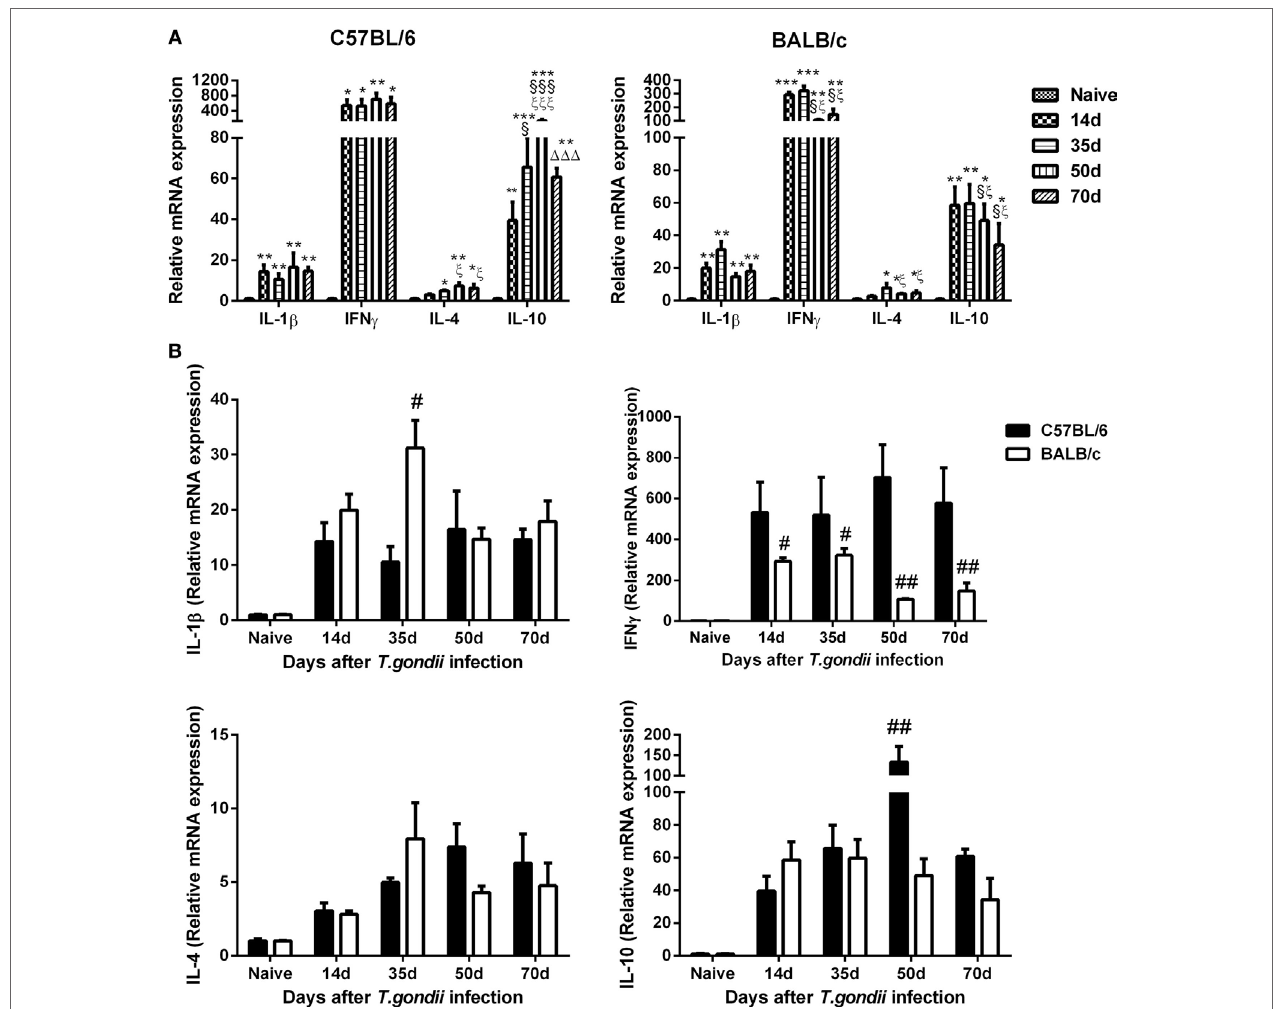
FigUre 4 | Relative mRNA expressions of interleukin (IL)-1 β , interferon gamma (IFN γ ), IL-4, and IL-10 in the brain tissues of Toxoplasma gondii Pru strain-infected C57BL/6 and BALB/c mice were detected by using quantitative real-time reverse transcription-polymerase chain reaction. (a) IL-1 β , IFN γ , IL-4, and IL-10 expressions in the brains of C57BL/6 and BALB/c mice. (B) Comparison of IL-1 β , IFN γ , IL-4, and IL-10 levels in the brains of C57BL/6 and BALB/c mice. Values are means from triplicate measurements, and data are presented as mean ± SD. There were four mice per group. The data shown are representative of those from two different experiments. * P < 0.05, ** P < 0.01, and *** P < 0.001 vs naive; § P < 0.05 and §§§ P < 0.001 vs 14 days post infection (p.i.); ξ P < 0.05 and ξξξ P < 0.001 vs 35 days p.i.; ΔΔΔ P < 0.001 vs 50 days p.i.; # P < 0.05 and ## P < 0.01 vs C57BL/6